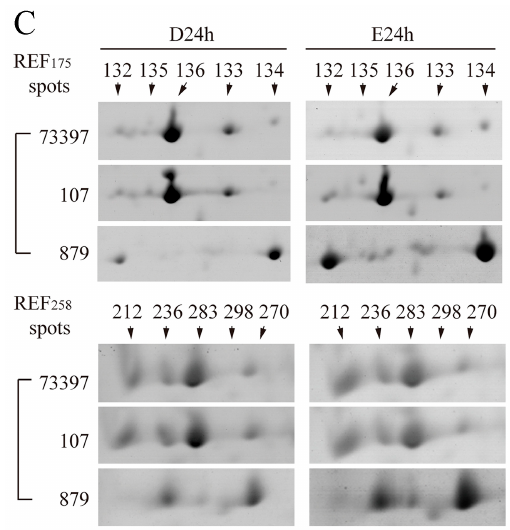
Figure 6. The abundance of the protein species of each REF/SRPP in high yielding and lower yielding clones of rubber tree upon ethylene treatment. ( A ) Clustering analysis of the relative abundance of the total protein and its protein species of each REF/SRPP after tapping and ethylene treatment. The abundance of each protein species in different treatments was normalized to their corresponding values in the control, CK; ( B ) Clustering analysis of the relative abundance of the total protein and the protein species of each REF/SRPP in rubber tree clones RY 7-33-97, PR 107 and RY 8-79. The abundance values of each protein or protein species were normalized to their corresponding values in RY 7-33-97; ( C ) 2-DE gel images of the protein species of REF 175 and REF 258 in rubber clones RY 7-33-97, PR 107 and RY 8-79. CK, the latex collected from the first tapping. D24h, D48h, D96h, latex from rubber trees at 24, 48, and 96 h under distilled water treatment. E24h, E48h, E96h, latex from rubber trees at 24, 48, and 96 h the under 3% ethephon treatment.